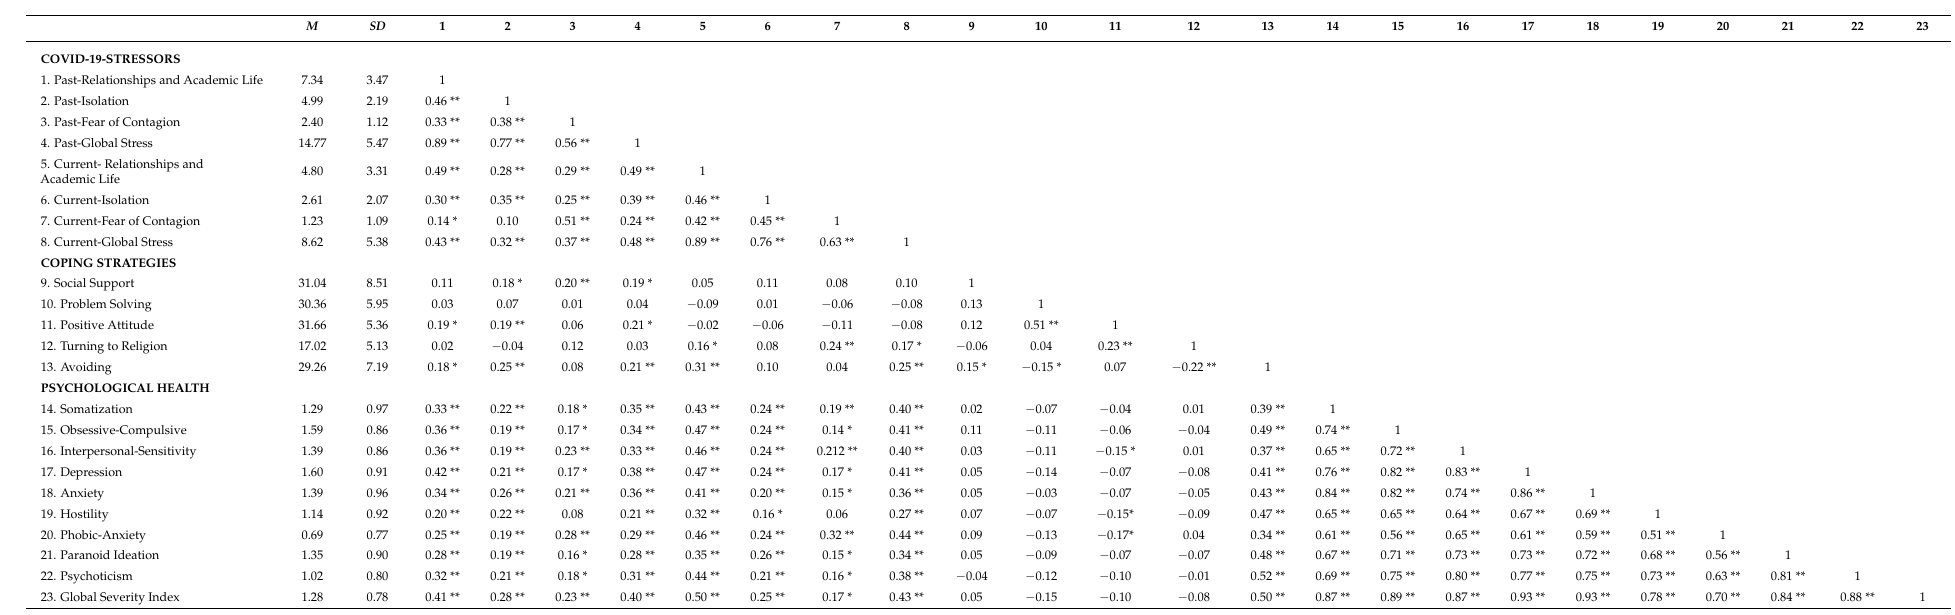
Table 1. Means, Standard Deviations, and Intercorrelations between study